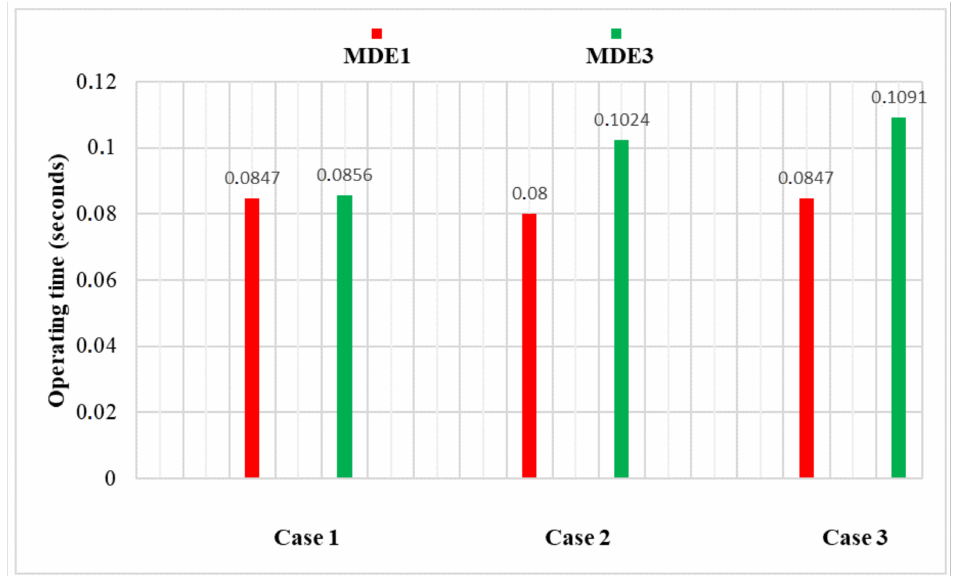
Figure 13. MDE1 and MDE3 settings’ performance with an exponentially varied scale